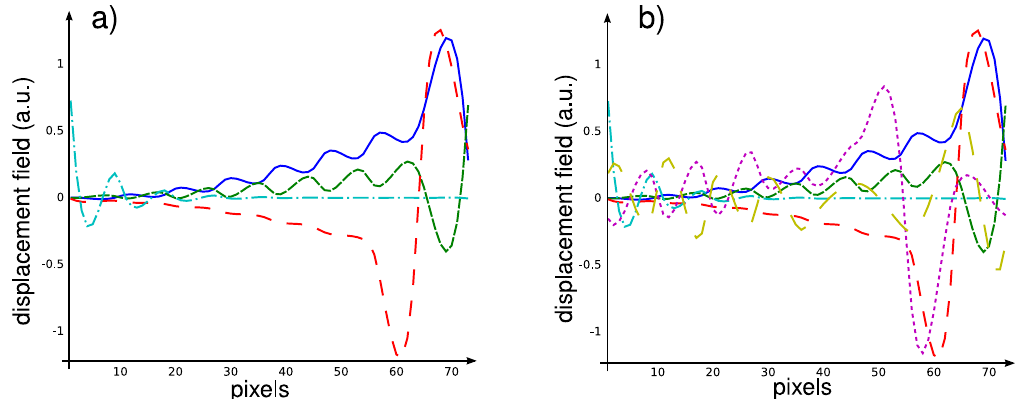
Fig. 2. a) Macro-scale displacement field basis obtained using a single macro element b) Macro-scale displace- ment field basis obtained using 2 macro